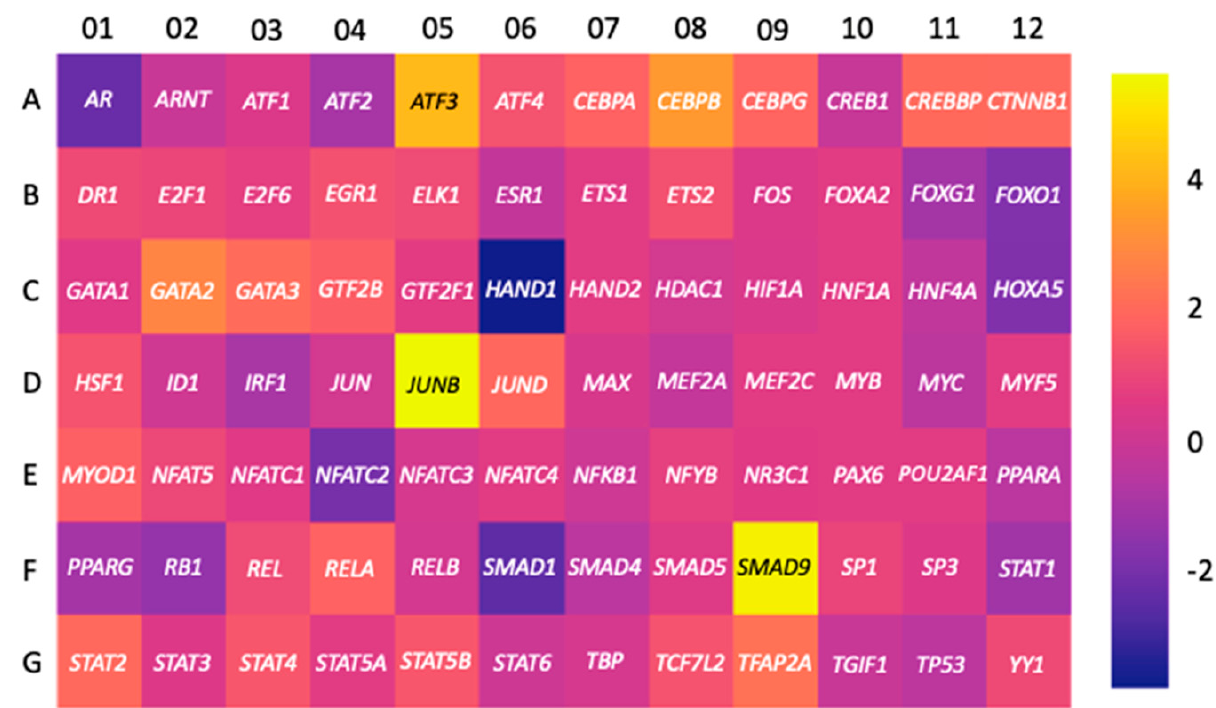
Figure 5. Changes in the expression of genes encoding TFs in JEG-3 cells. Cells were treated 8 − Br − cAMP (250 µM) for 36 h to induce trophoblastic differentiation and Qiagen RT 2 Profiler™ PCR Array kit was used to assess fold changes in gene expression between differentiated and control cells presented as a heatmap.